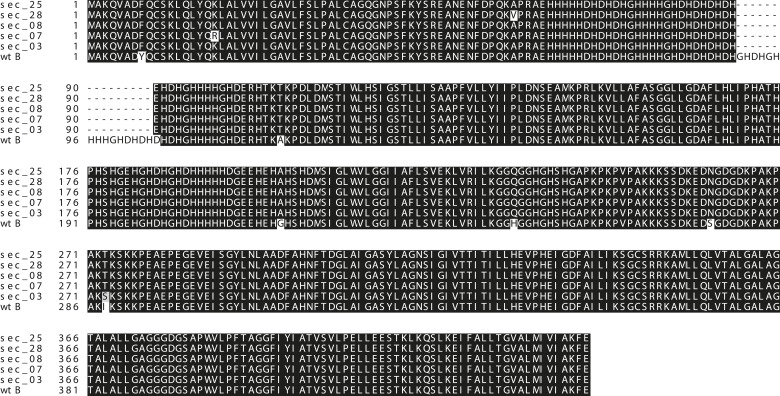
Conserved Catsup sequence in D. sechellia.Drosophila CATSUP amino acids sequence showing deletions (dash) and exchanges (grey or white) of amino acids in D. sechellia (14021–0248.03 (sec_03), 14021–0248.07 (sec_07), 14021–0248.08 (sec_08), 14021–0248.25 (sec_25), 14021–0248.28 (sec_28)) compared to in D. melanogaster wild-type Berlin (wtB).